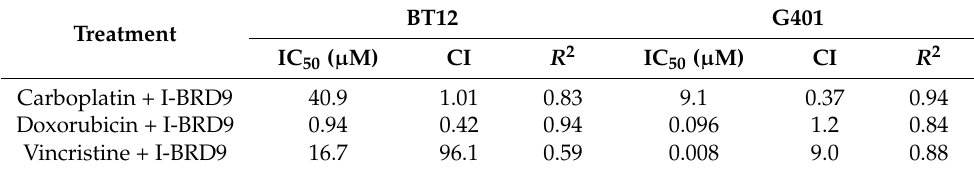
Figure 4. Combination indices (CI) of I-BRD9 combined with carboplatin, doxorubicin or vincristine. Data from cytotoxicity assays were analyzed by median effect method of Chou and Talalay. Dotted line marks CI = 1. CI < 1 indicates synergism, CI > 1 antagonism of combined drugs. ( n ≥ 3). Table 4. IC 50 and combination indices (CI) of combined treatments. Treatment of BT12 and G401 with combinations of I-BRD9 and three cytotoxic drugs for 72 h. CI < 1 indicates synergistic effects and CI > 1 antagonistic effects of combined drugs. R 2 represents the determination coefficient of linear regression in median effect plot. ( n ≥ 3).